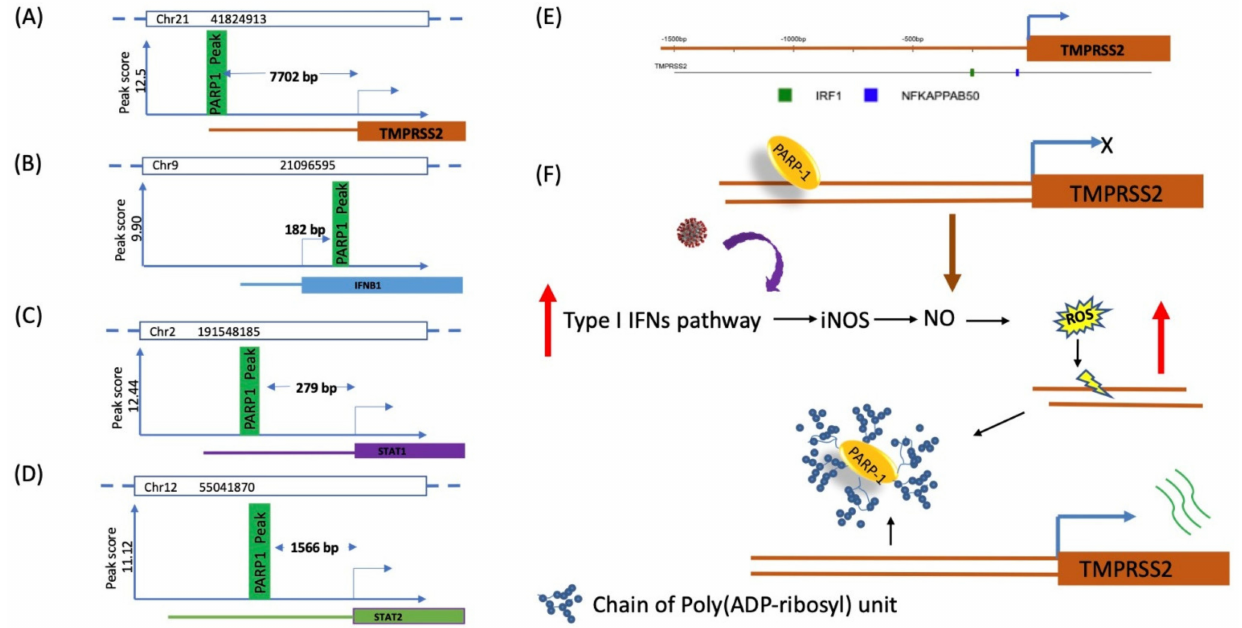
Figure 2. Binding sites of PARP1 on promoter or downstream regions of different immune-regulatory genes. PARP1 binds to TMPRSS2, IFN β , and JAK/STAT pathway genes either upstream or downstream to TSS. These PARP1 binding sites were reported by Lodhi et al. 2014 [37] and derived from their ChIP-seq data. Chromosome numbers and PARP1 binding locations are indicated in each figure. ( A ). PARP1 binds to about 7.7 kb upstream to TSS of TMPRSS2. ( B ). PARP1 binds just 182 bp downstream to TSS IFN β promoter. ( C ). PARP1 binding to STAT1 promoter in the upstream region at 279 bp; it is not known how PARP1 is involved in the transcription regulation of this gene. ( D ). There is a PARP1 binding site in the upstream region around 1.5 kb promoter of STAT2. ( E ). Using www.interferome.org, we generated transcription binding sites in the promoter region of TMPRSS2, which has been developed using interferome (www.interferome.org). The location of transcription factors on each of the genes from the region spanning − 1500 bp to +500 bp from the start site. Each coloured box represents a specific transcription factor, the key for which is provided below the graphic. TRANSFAC* predicted a match between the transcription factor and its predicted binding [34]. ( F ). Induced enzymatic activity of PARP1 auto-poly(ADP-ribosyl)ates, subsequently followed by SARS-CoV-2 infection. Virus internalization through ACE2 receptors and priming of viral S protein by residual TMPRSS2. TLR3/7 recognizes the PAMPs and induces the type I IFN pathway, which leads to the production of iNOS and, therefore, NO. Increase of NO creates ROS in cells, which causes DNA damage and a reason for PARP1 activation. Auto-poly(ADP-ribosyl)ated PARP1 moves away from the binding site, and it may increase the transcription of TMPRSS2, hence facilitating virus